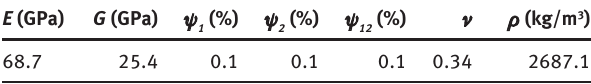
Table 4: Aluminium skin elastic and damping data [5].